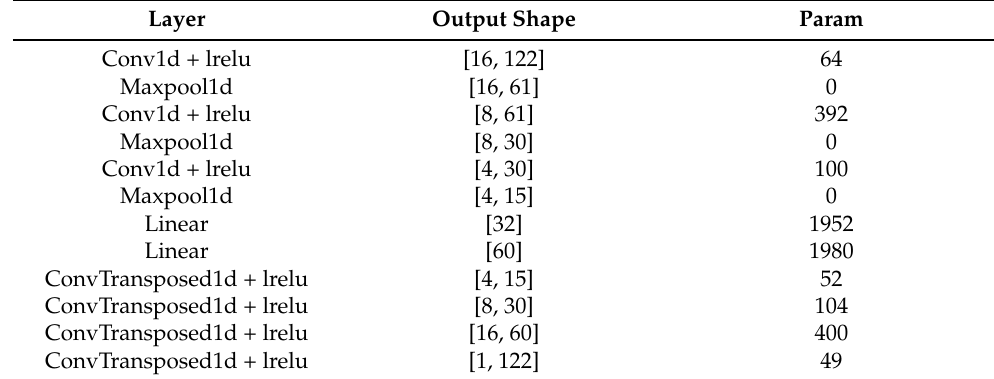
Table 2. Detailed parameter list for the proposed model.